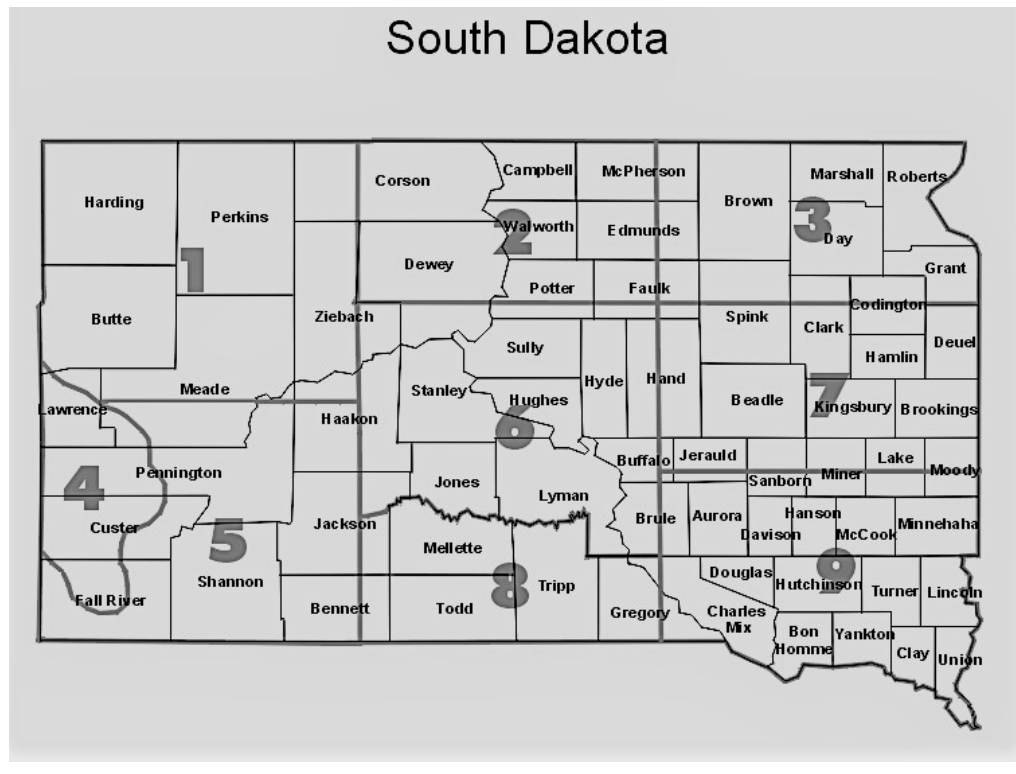
Figure 1. The nine climate divisions of South Dakota with underlying counties named and outlined. Figure adapted from the Climate Prediction Center, National Oceanic and Atmospheric Administration.